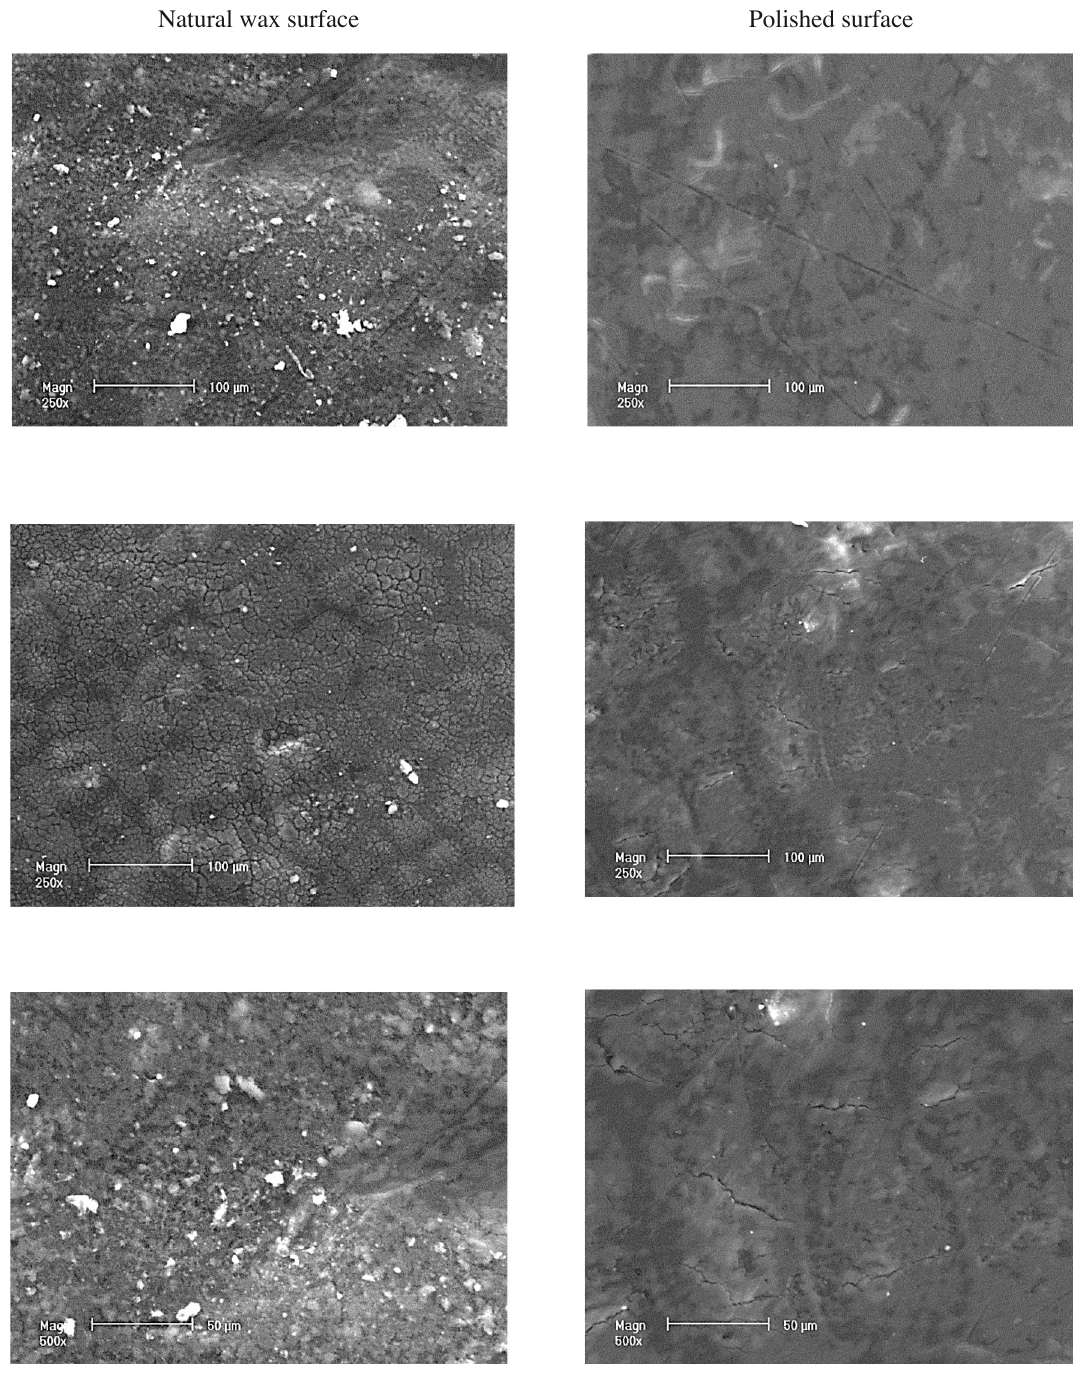
Fig. 2: Micrographs of the blueberry fruit surfaces with their natural wax surface (left) and after polishing (right hand column); scale bar indicates 100 μm (top) or 50 μm (bottom line).